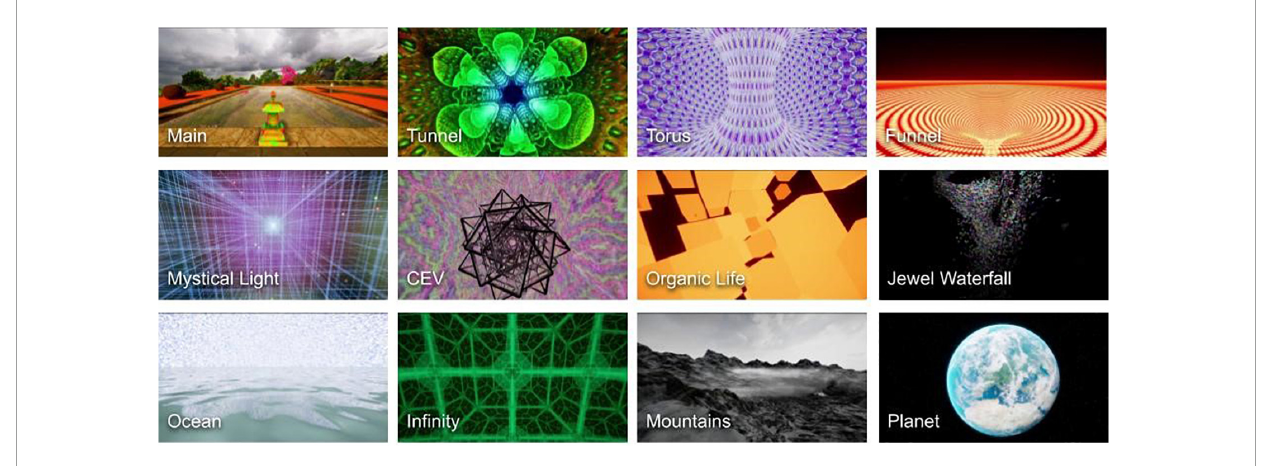
FIGURE1 Screenshots of some of the environments in Psyrreal shown in sequence to exemplify the diversity of visuals presented to the user during the experience. The experience starts in a temple (top left) , progresses through different levels of varying abstraction and intensity, and culminates in outer space (bottom right) . See also Supplementary material 1 for more illustrations of the environments and Table 1 for more detailed descriptions of the implemented concepts. CEV stands for “closed-eye